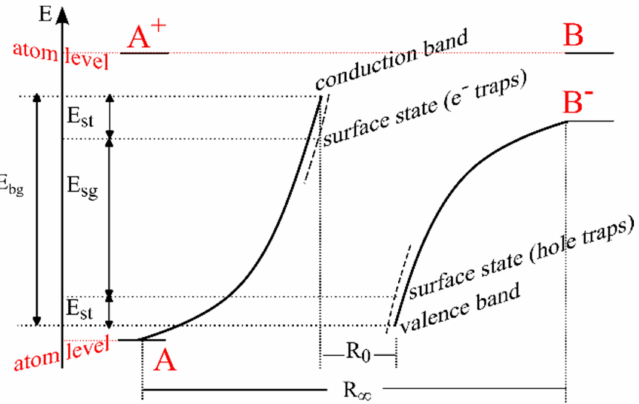
Figure 8. Classical energy diagram of Madelung-Seitz in ionic crystals of type AB. Adapted from